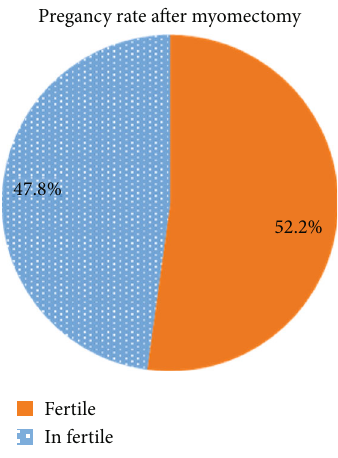
Figure 1: Pregnancy after